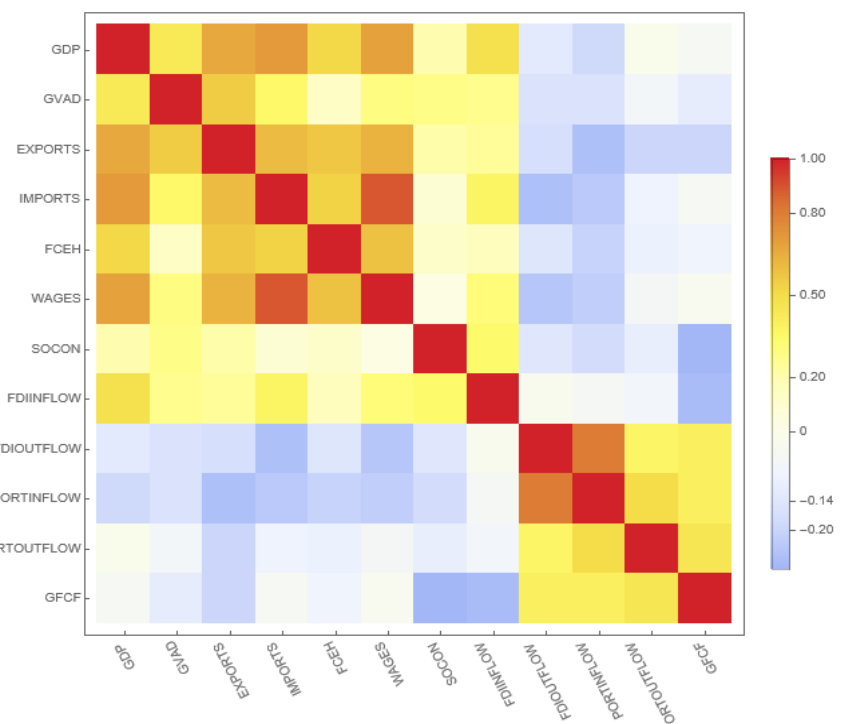
Figure 2. Kendall correlation coefficient of variables.